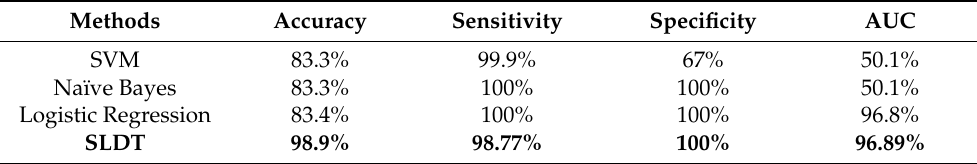
Table 8. Performance measures of the proposed method with other machine learning methods in the combined dataset 2 including NLM, Belarus, and